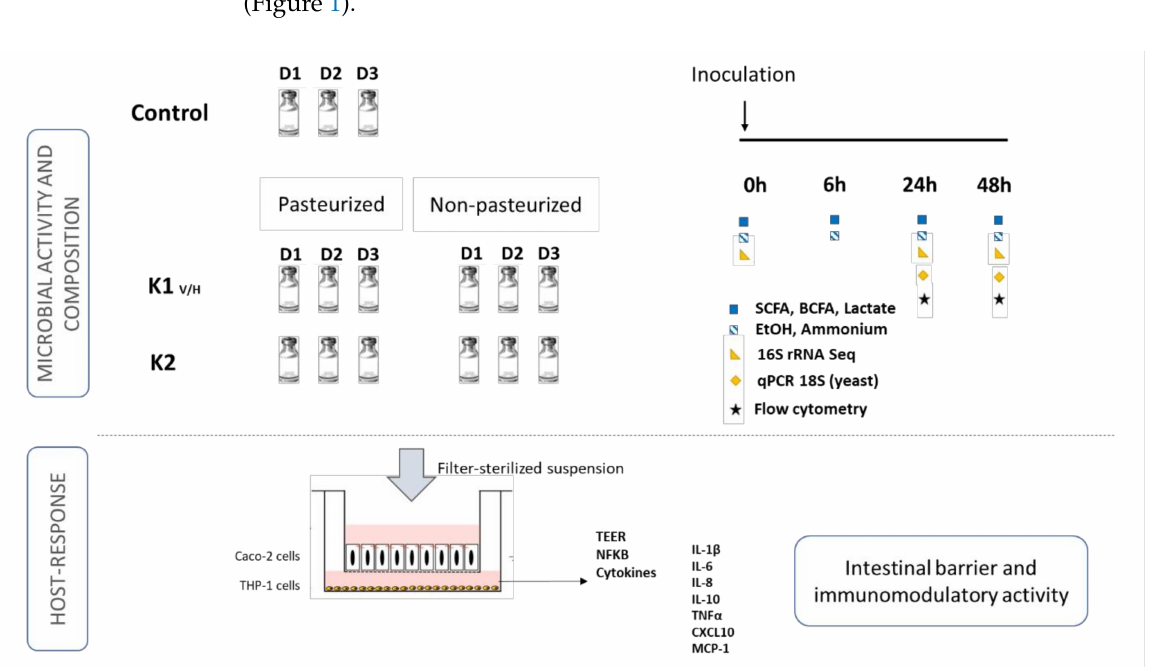
Figure 1. Schematic representation of the experimental set up. SFCA = short-chain fatty acid; BCFA = branched-chain fatty acid; EtOH = ethanol; TEER = transepithelial electrical resistance. D = donor; K =